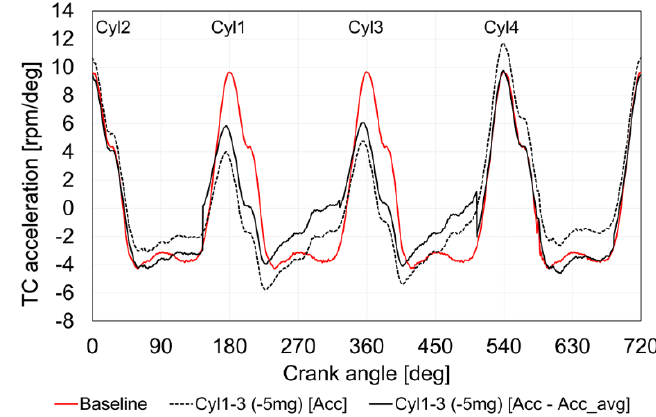
Figure 2. Example of the TC acceleration in case of two engine operating conditions (numerical results): base injection and same injection variation in cylinder 1 and cylinder 3 (-5 mg). The continuous black line is the scaled instantaneous TC acceleration reduced by the mean value for each cylinder-window.